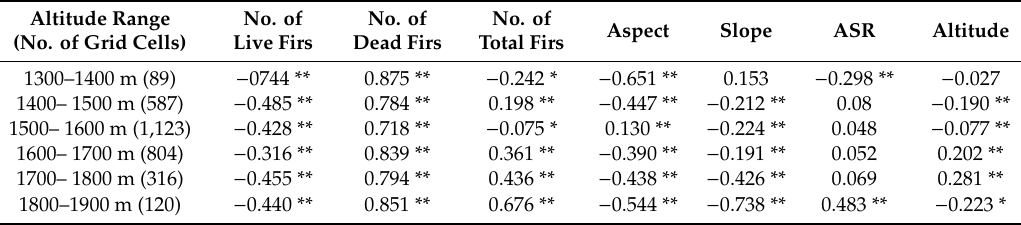
Table 7. Pearson correlation analysis between APMR and other factors within each 100 m altitudinal interval.